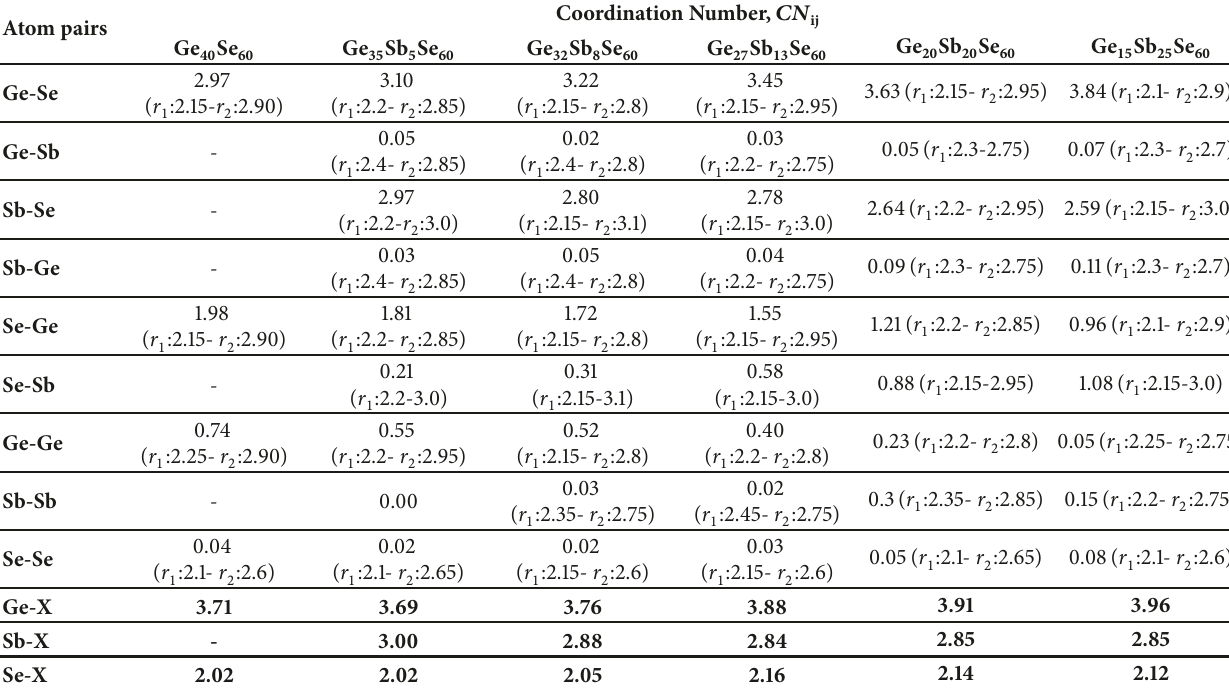
Table 4: Average coordination numbers, 𝐶𝑁 ij , calculated from the RMC simulation. In brackets are indicated the intervals of r within which the atoms are counted as neighbours and, thus, the actual coordination numbers are calculated. The error is ∼ 5% for Ge-Se, Sb-Se, Se-Ge and ∼ 10% for Ge-Sb, Sb-Ge, Se-Sb, Ge-Ge, Sb-Sb, Se-Se. The total coordination distributions are signed by Ge-X for Ge, Sb-X for Sb, and Se-X for Se